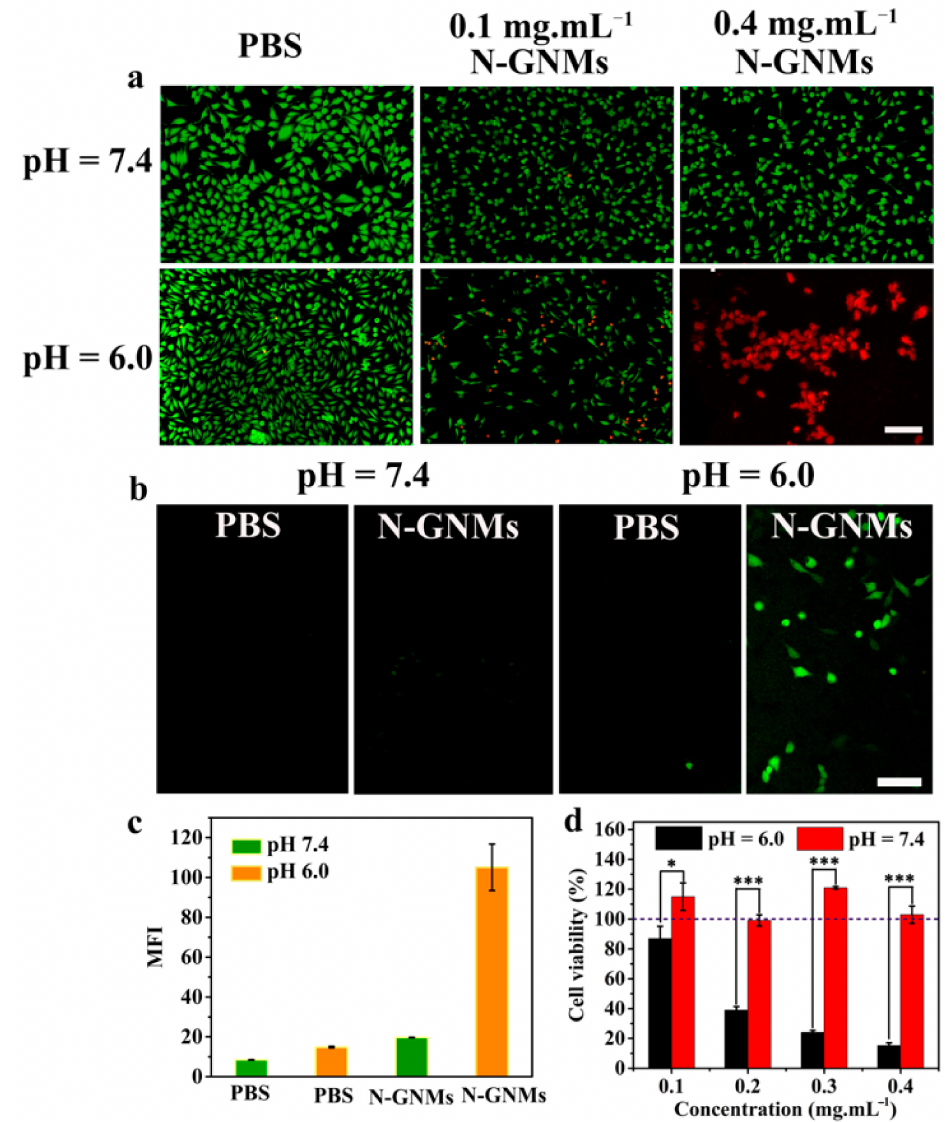
Figure 5. In vitro therapeutic efficacy of N-GNMs. ( a ) Live/dead assay of HeLa tumor cells incubated with 0.40 mg/mL − 1 N-GNMs under acidic and neutral conditions for 24 h. The cells were stained using calcein-AM/PI. Scale bar: 200 µ m; ( b ) HeLa tumor cells incubated with 0.40 mg/mL − 1 N- GNMs in acidic and neutral media that contained the reactive oxygen species (ROS) fluorescent probe 2 (cid:48) ,7 (cid:48) -dichlorofluorescein diacetate (DCFH-DA) for 24 h. Scale bar: 200 µ m; ( c ) The mean fluorescence intensity (MFI) of HeLa cells treated with PBS or N-GNMs (0.4 mg/mL − 1 ) for 12 h was stained with DCFH; ( d ) Cell viability (as determined by the CCK-8 assay) of HeLa cells treated with N-GNMs under acidic and neutral conditions (* p < 0.05, *** p < 0.001, two-tailed t